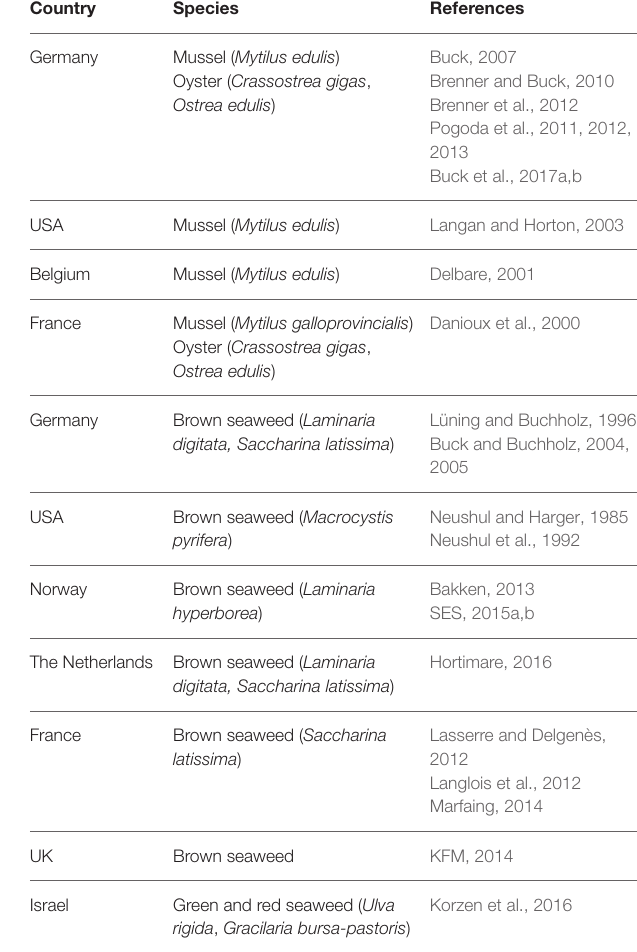
TABLE 1 | Long-term experiments with extractive species (mussel, oyster, seaweed) culture systems conducted in harsh hydrodynamic conditions in the open